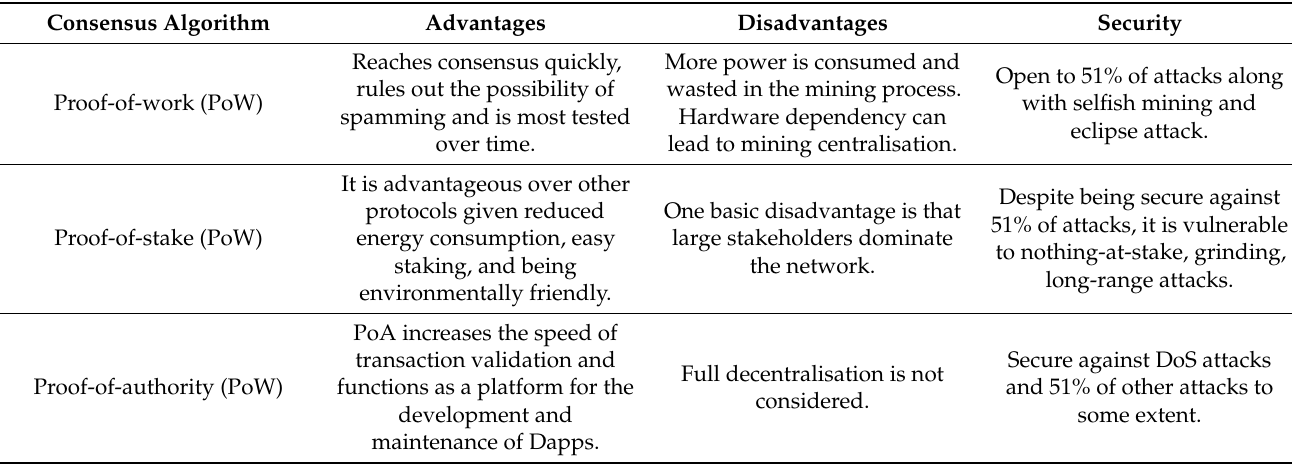
Table 3. The main comparisons between consensus algorithms